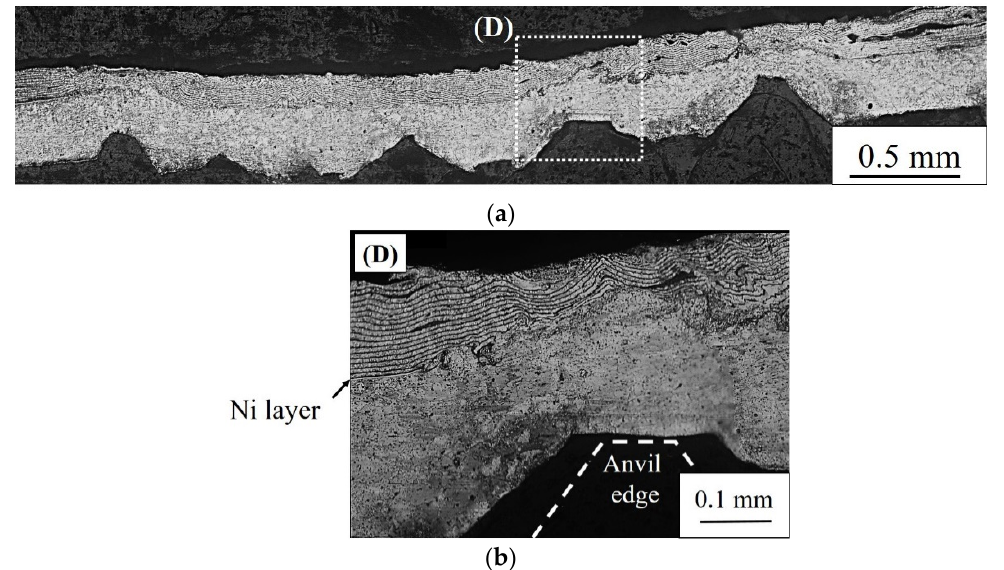
Figure 13. Optical micrographs of cross sections obtained using the C-type tool: ( a ) entire bonded region and ( b ) magnified version of (D).